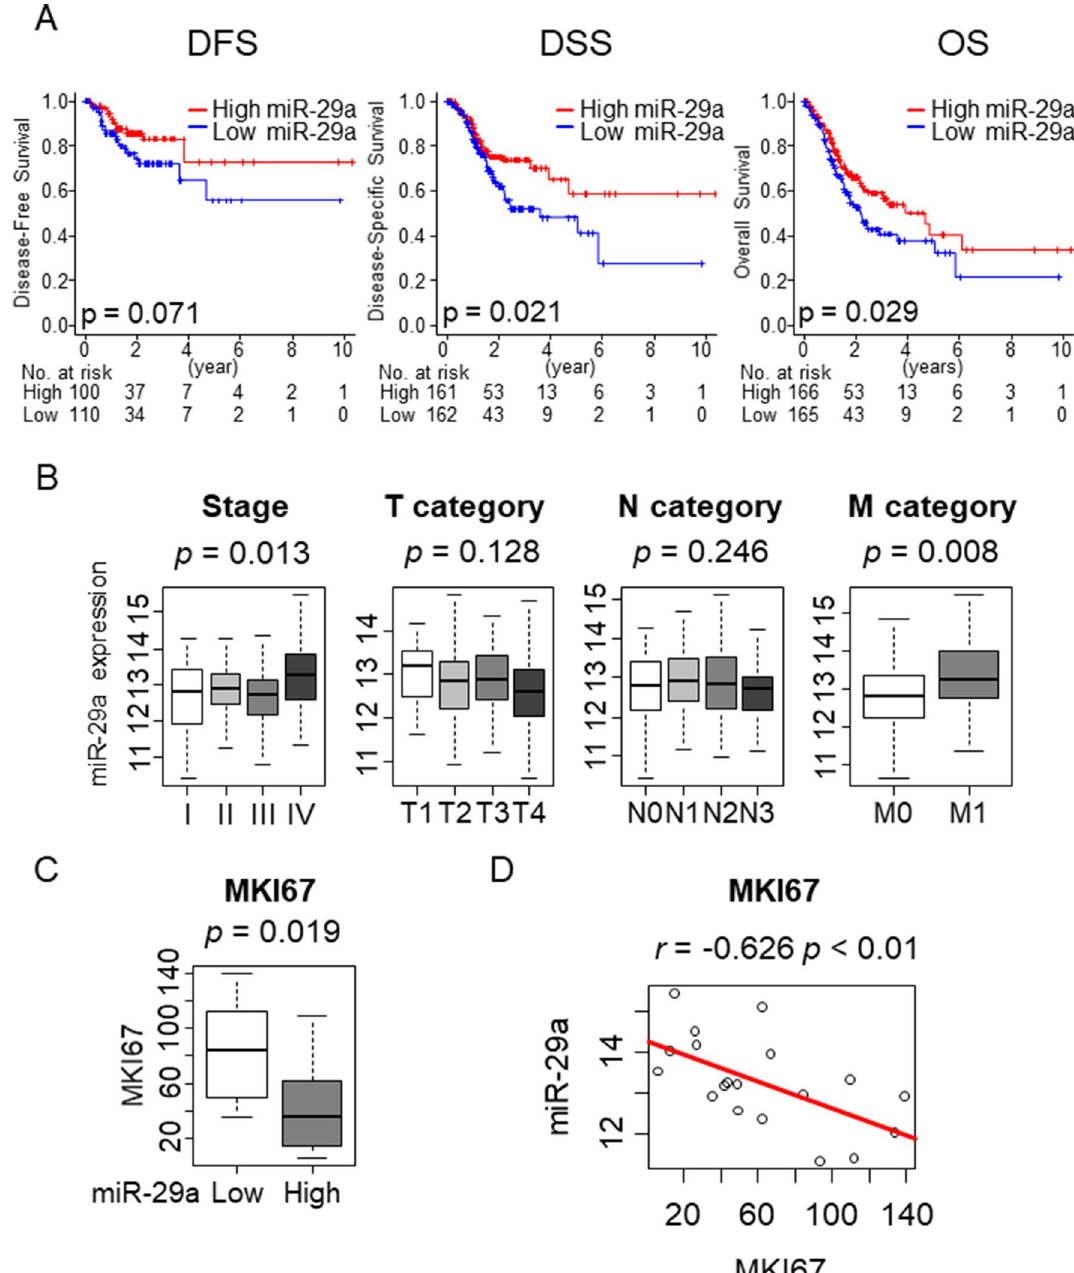
Figure 5. Survival analysis of miR-29a and the association between miR-29a and clinical stage in whole cohort as well as the association between miR-29a and MKI67 expression in M1 gastric cancer patients ( A ) Kaplan Meier survival analysis of miR-29a. Blue line represents miR-29a low expressing tumors and red line represents miR-29a high expressing tumors. ( B ) The association between miR-29a and stage and TNM categories. ( C ) The association between miR-29a and MKI67 expression in M1 gastric cancer patients. ( D ) The correlation analysis between miR-29a and MKI67 in M1 gastric cancer patients. DFS disease-free survival, DSS disease- specific survival, OS overall survival. The statistical significance was defined by p < 0.05. Tukey-type boxplots demonstrate median and inter-quartile level values. r represents a Spearman’s correlation